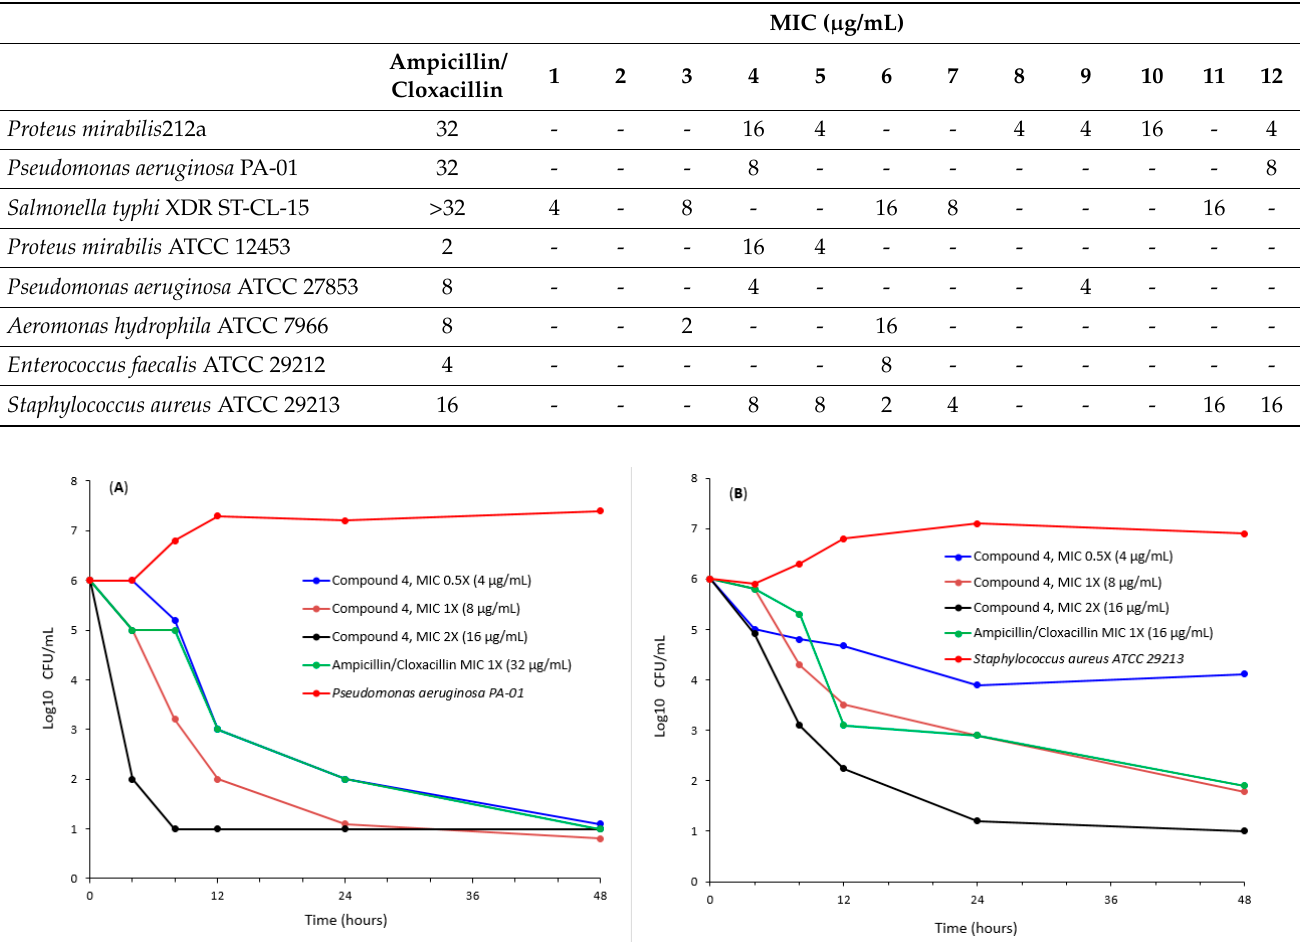
Table 2. In vitro antibacterial activities of lipophilic hydrazides against the Gram-positive and Gram-negative bacterial species.